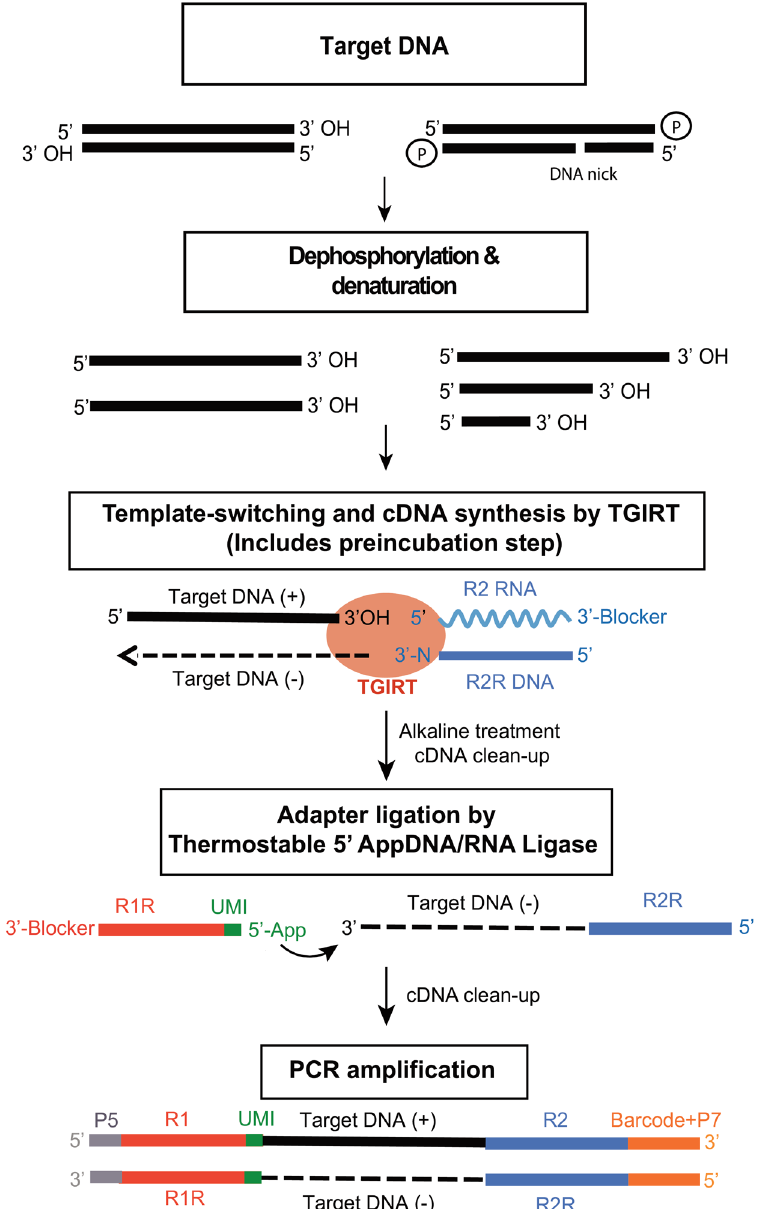
Figure 1. TGIRT ssDNA-seq workflow. The target DNA (2–50 ng in this work) is treated with alkaline phosphatase to remove 3 ′ phosphates and heat denatured prior to DNA-seq library construction. The resulting ssDNAs with 3 ′ OH termini are then used for TGIRT template-switching DNA synthesis coupled to Illumina read 2 reverse (R2R) DNA-seq adapter addition. In this novel reaction, the TGIRT-III enzyme (InGex) binds first to a synthetic 34-bp R2 RNA/R2R DNA heteroduplex in which the R2R DNA primer has a single nucleotide 3 ′ overhang that can direct TGIRT template switching by base pairing to the 3 ′ nucleotide of a target DNA strand. For minimally biased library preparation, the 3 ′ -overhang nucleotide is an equimolar mixture of A, C, G, and T (denoted N). A 3 ′ -blocking group (C3 spacer; 3 ′ SpC3) is attached to the end of the R2 RNA oligonucleotide to prevent template-switching to that RNA. After the TGIRT enzyme extends the DNA primer to produce a DNA copy of the target DNA strand with an R2R adapter seamlessly linked to its 5 ′ end, a 5 ′ adenylated (App) Illumina read 1 reverse (R1R) adapter is added to its 3 ′ end by single-stranded DNA ligation using a Thermostable 5 ′ AppDNA/RNA ligase (New England Biolabs). In the workflow shown, an unique molecular identifier (UMI) is positioned at the 5 ′ end of the R1R DNA oligonucleotide. A final PCR step adds flow cell capture sites and barcodes for Illumina sequencing and sample